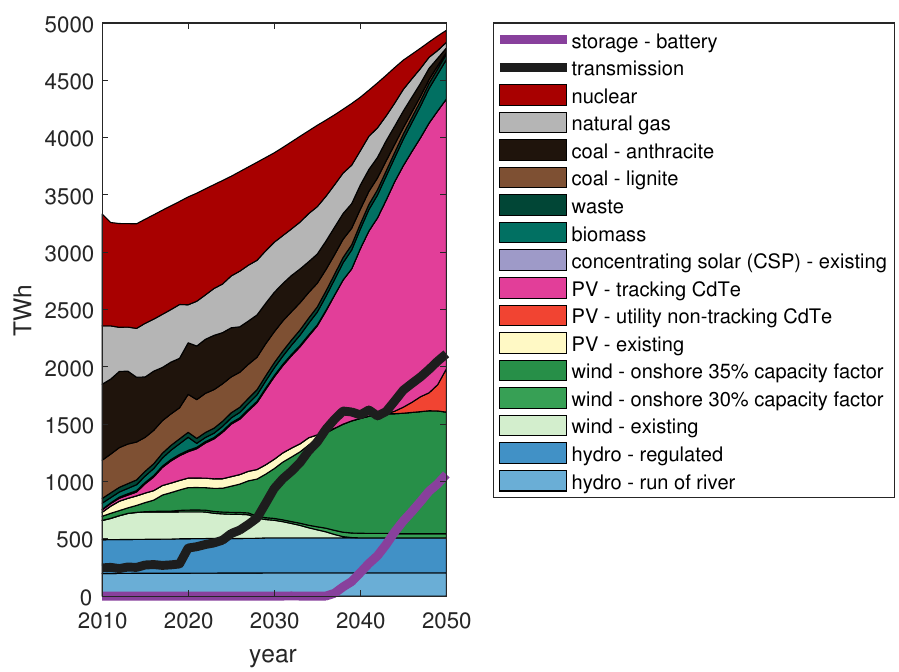
Figure 3. Electricity generated by generation type and year plus yearly electricity transmitted internationally and yearly energy transferred to storage in the lower solar cost